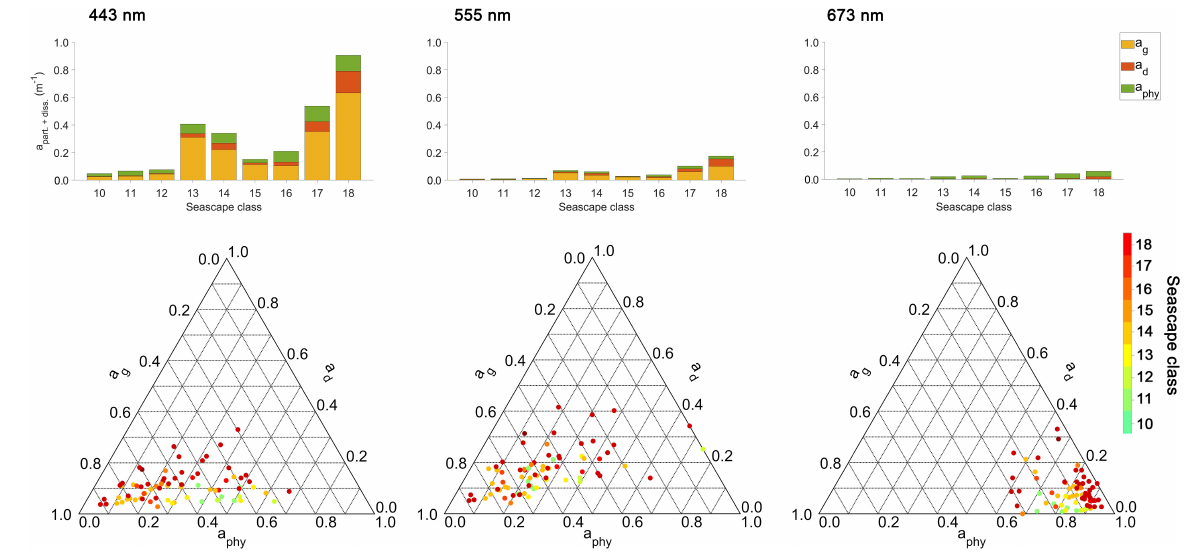
FIGURE 6 | Absorption budgets for particulate and dissolved phases of individual seascape classes at 443, 555, and 675 nm bands. The top row shows absorption levels of particulate and dissolved components measured in sampled seascape classes at corresponding bands. The bottom row shows distributions of fractional absorption coefficients for phytoplankton (a phy ), detritus (or non-algal particles; a d ), and Colored Dissolved Organic Matter (CDOM; a g ) and corresponding wavelengths above [ternary plots generated using (Ulrich,